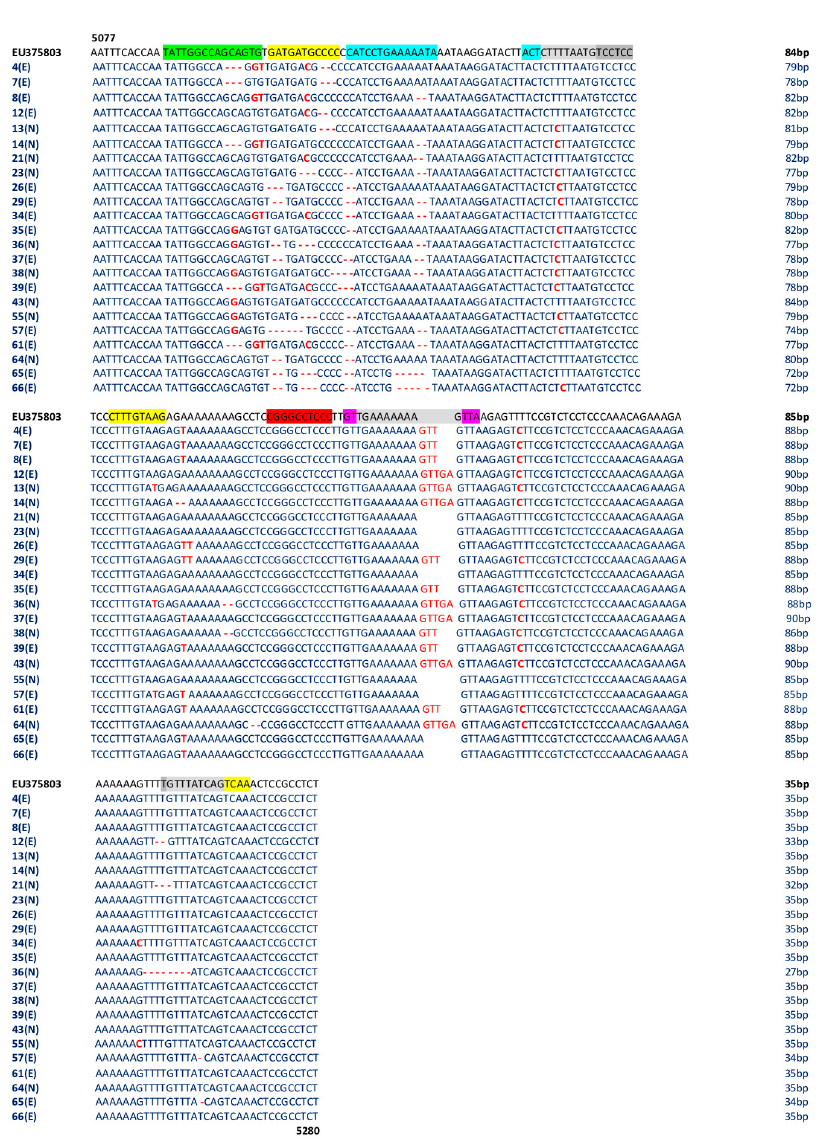
Figure 4. Sequence analysis of the MCPyV NCCR recovered from rectal swabs. The alignment is shown between the nucleotide sequence from 5077 to 5280 of the published sequence of MCPyV